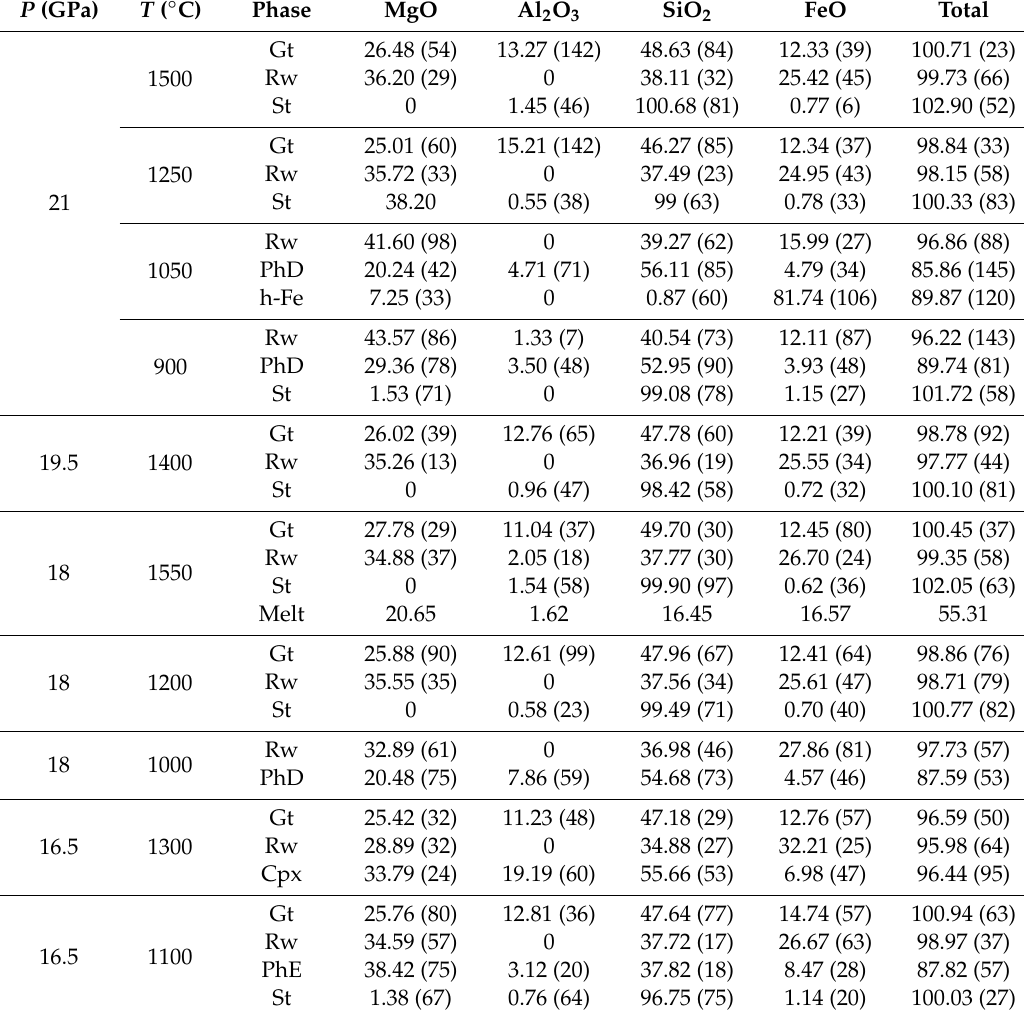
Table 3. Representative mineral